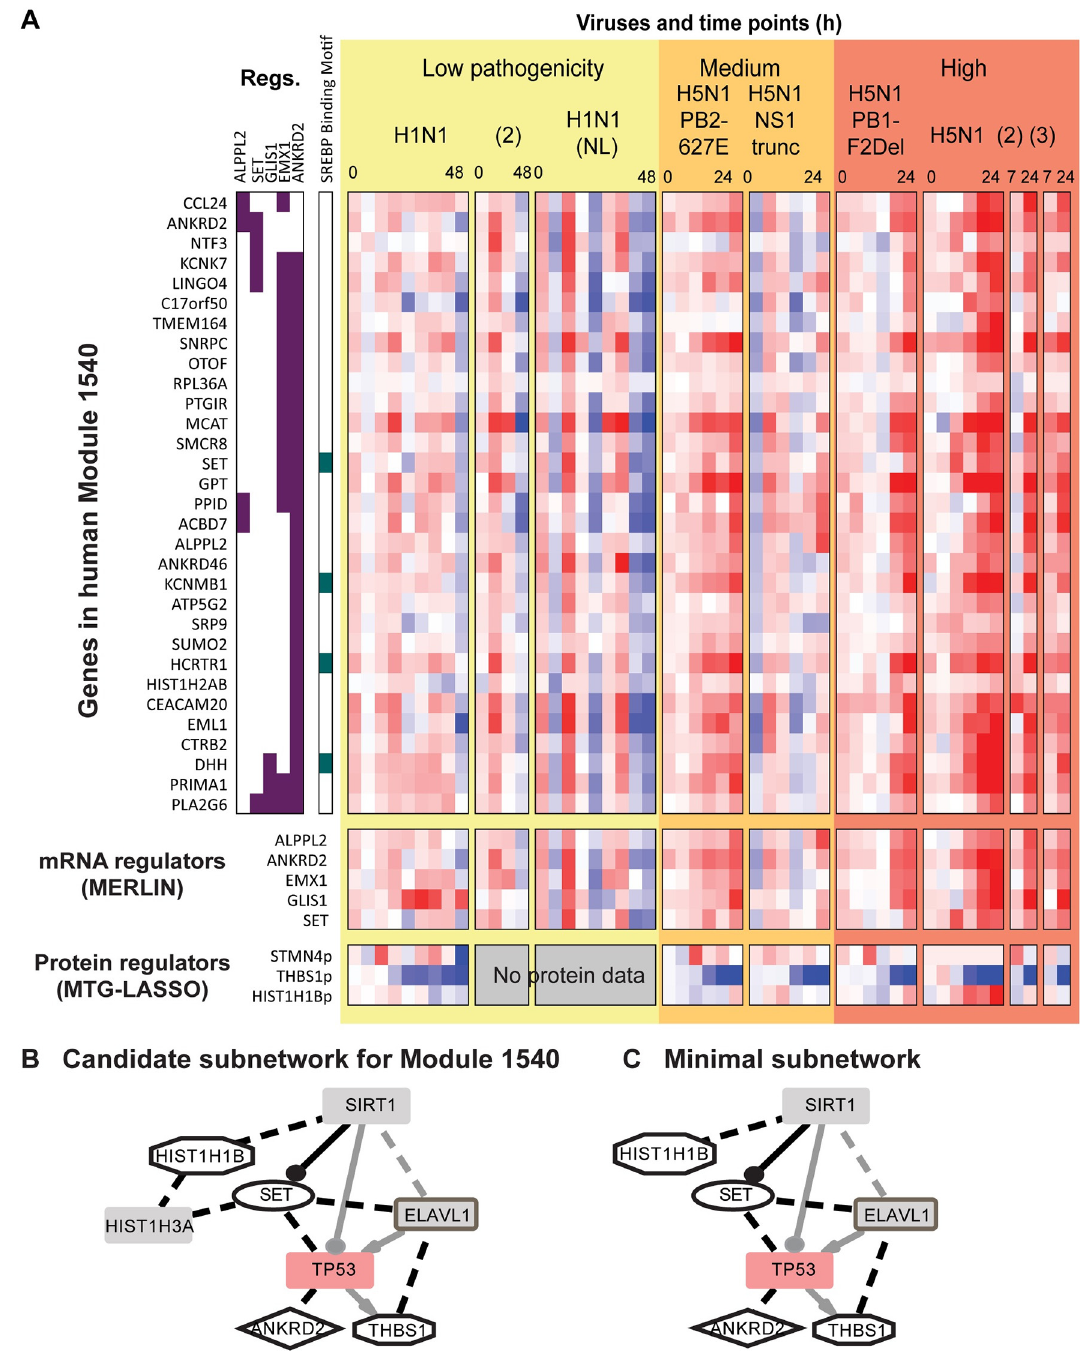
Fig 9. Target and regulator expression profile and the physical regulatory program of Module 1540. A. Heatmap visualization of module 1540 genes and regulators. In the “ Regs ” columns, consensus MERLIN regulators for each gene are marked with purple boxes. Next, genes with SREBP binding motif are marked in green. Below the heatmap for module genes are rows for MERLIN-predicted mRNA regulators and MTGLASSO-predicted protein regulators. Gene expression values are scaled (-2,2); protein values are scaled (-1,1) to improve visibility. B. Original subnetwork for Cluster 1540. Black edges link regulators to intermediates; these are provided as input to the ILP method. Additional interactions from the background network between regulators and intermediates are shown in grey. See Fig 7B for additional legend details. C. Minimal subnetwork for Cluster 1540, output from the ILP-based subnetwork inference method. Compared to the original subnetwork, the minimal subnetwork prunes away one protein: HIST1H3A. See Fig 7B for legend.